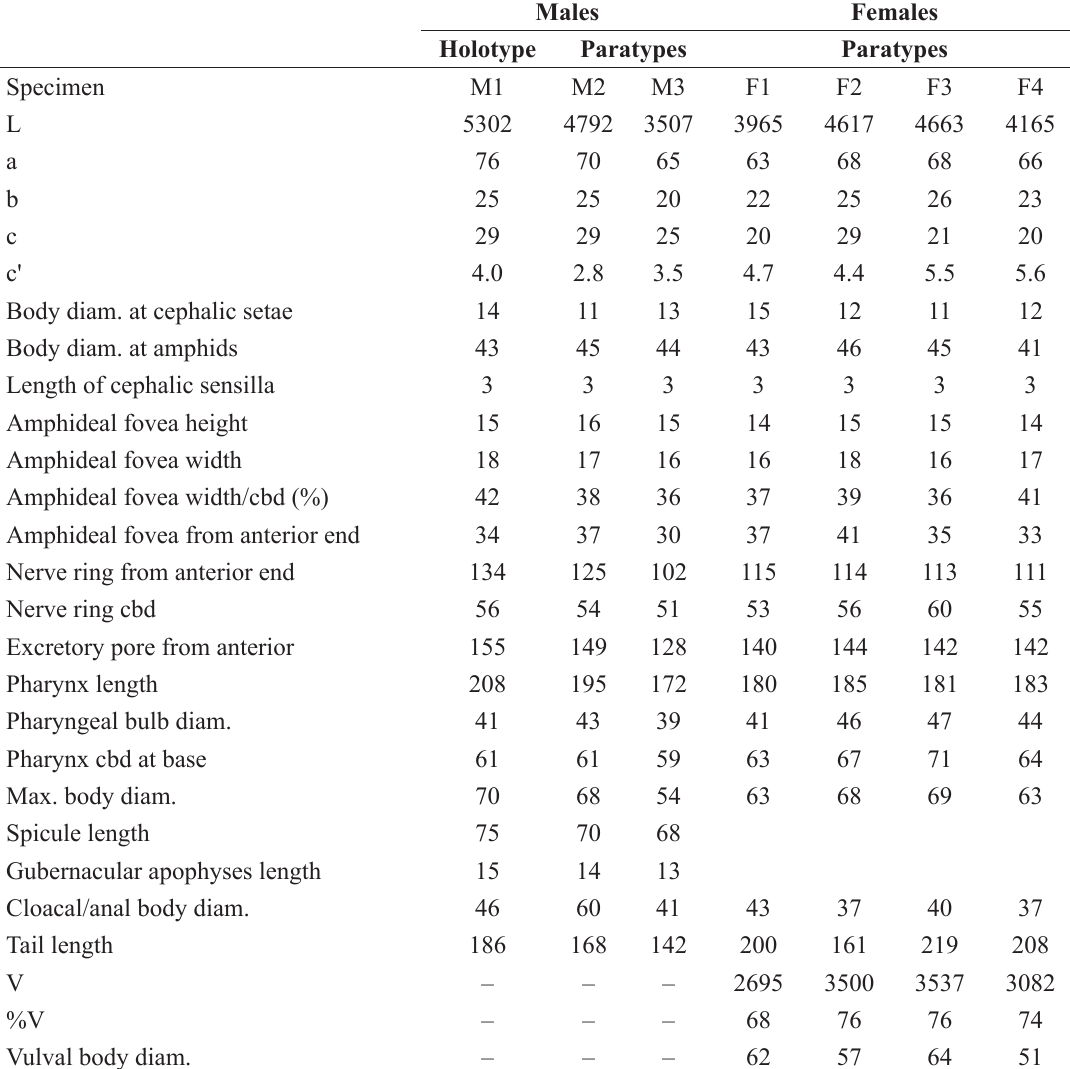
Table 2. Morphometrics (µm) of Siphonolaimus curtisensillus sp. nov. Abbreviations: a = body length/ maximum body diameter; b = body length/pharynx length; c = body length/tail length; cʹ = tail length/ anal or cloacal body diameter; cbd = corresponding body diameter; L = total body length; V = vulva distance from anterior end of body; %V = V/total body length ×